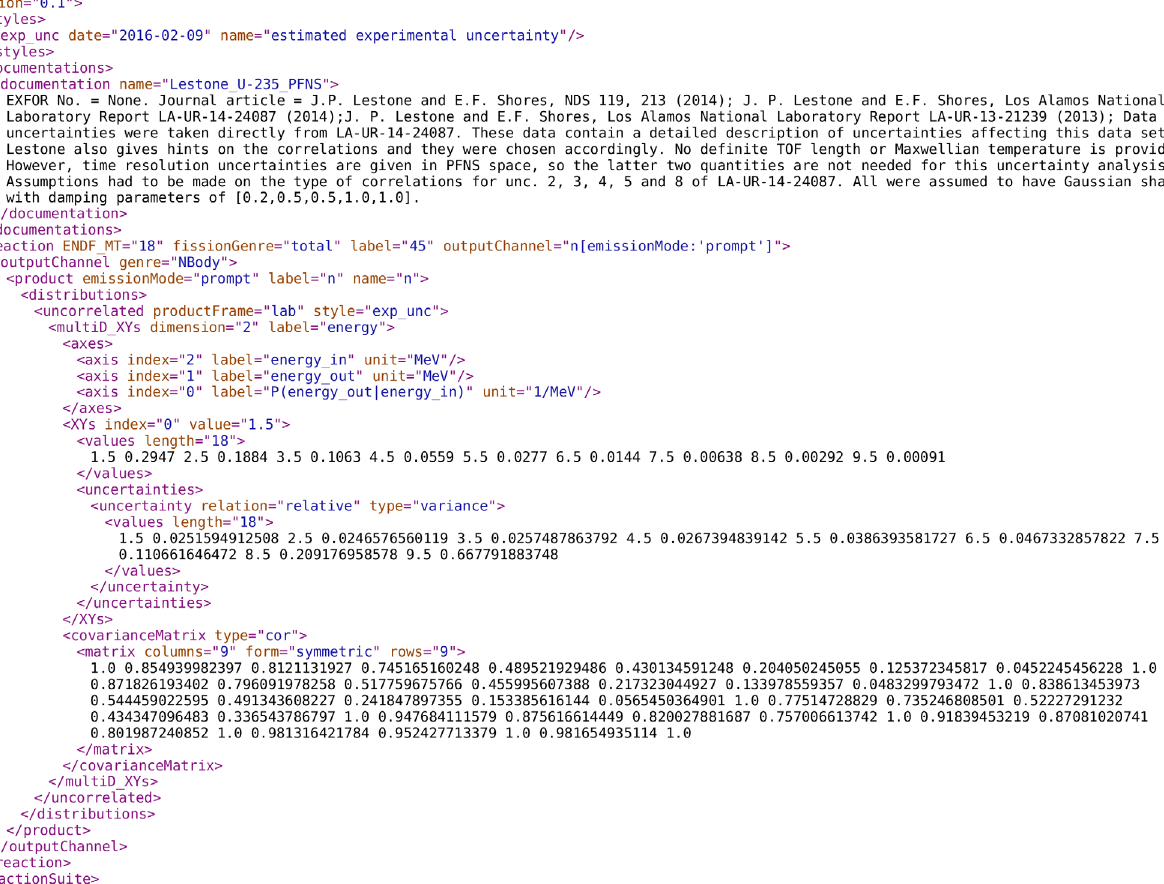
Fig. 6. The GND formatted XML output fi le automatically generated by ARIADNE with the input deck of Figure 2 is shown. It contains a documentation, the incident and outgoing neutron energies, the data, total relative uncertainties and associated